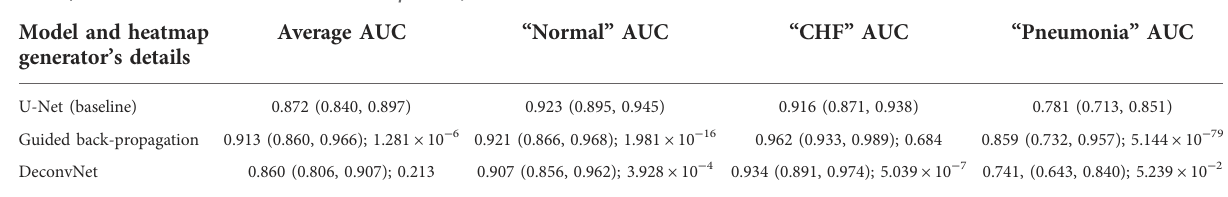
TABLE 4 Comparing the output AUC values between (12) ’ s U-Net model and a U-Net with different derived heatmaps (GBP or deconvNet) for the Experiment Set 3 (the value preceding the parenthesis is the 50th percentile value and the values in parenthesis are 2.5th and 97.5th percentile values, and the value after a semicolon is the p